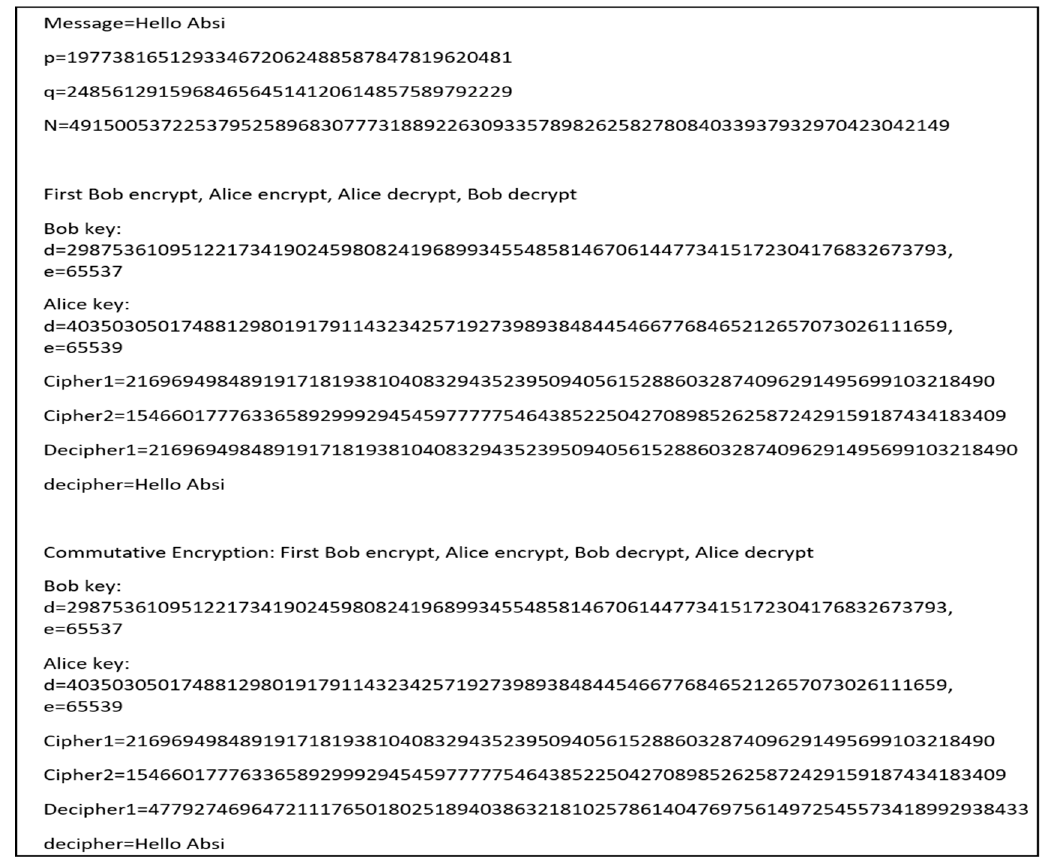
Figure 5. Encryption in the correct order and then in the incorrect order.